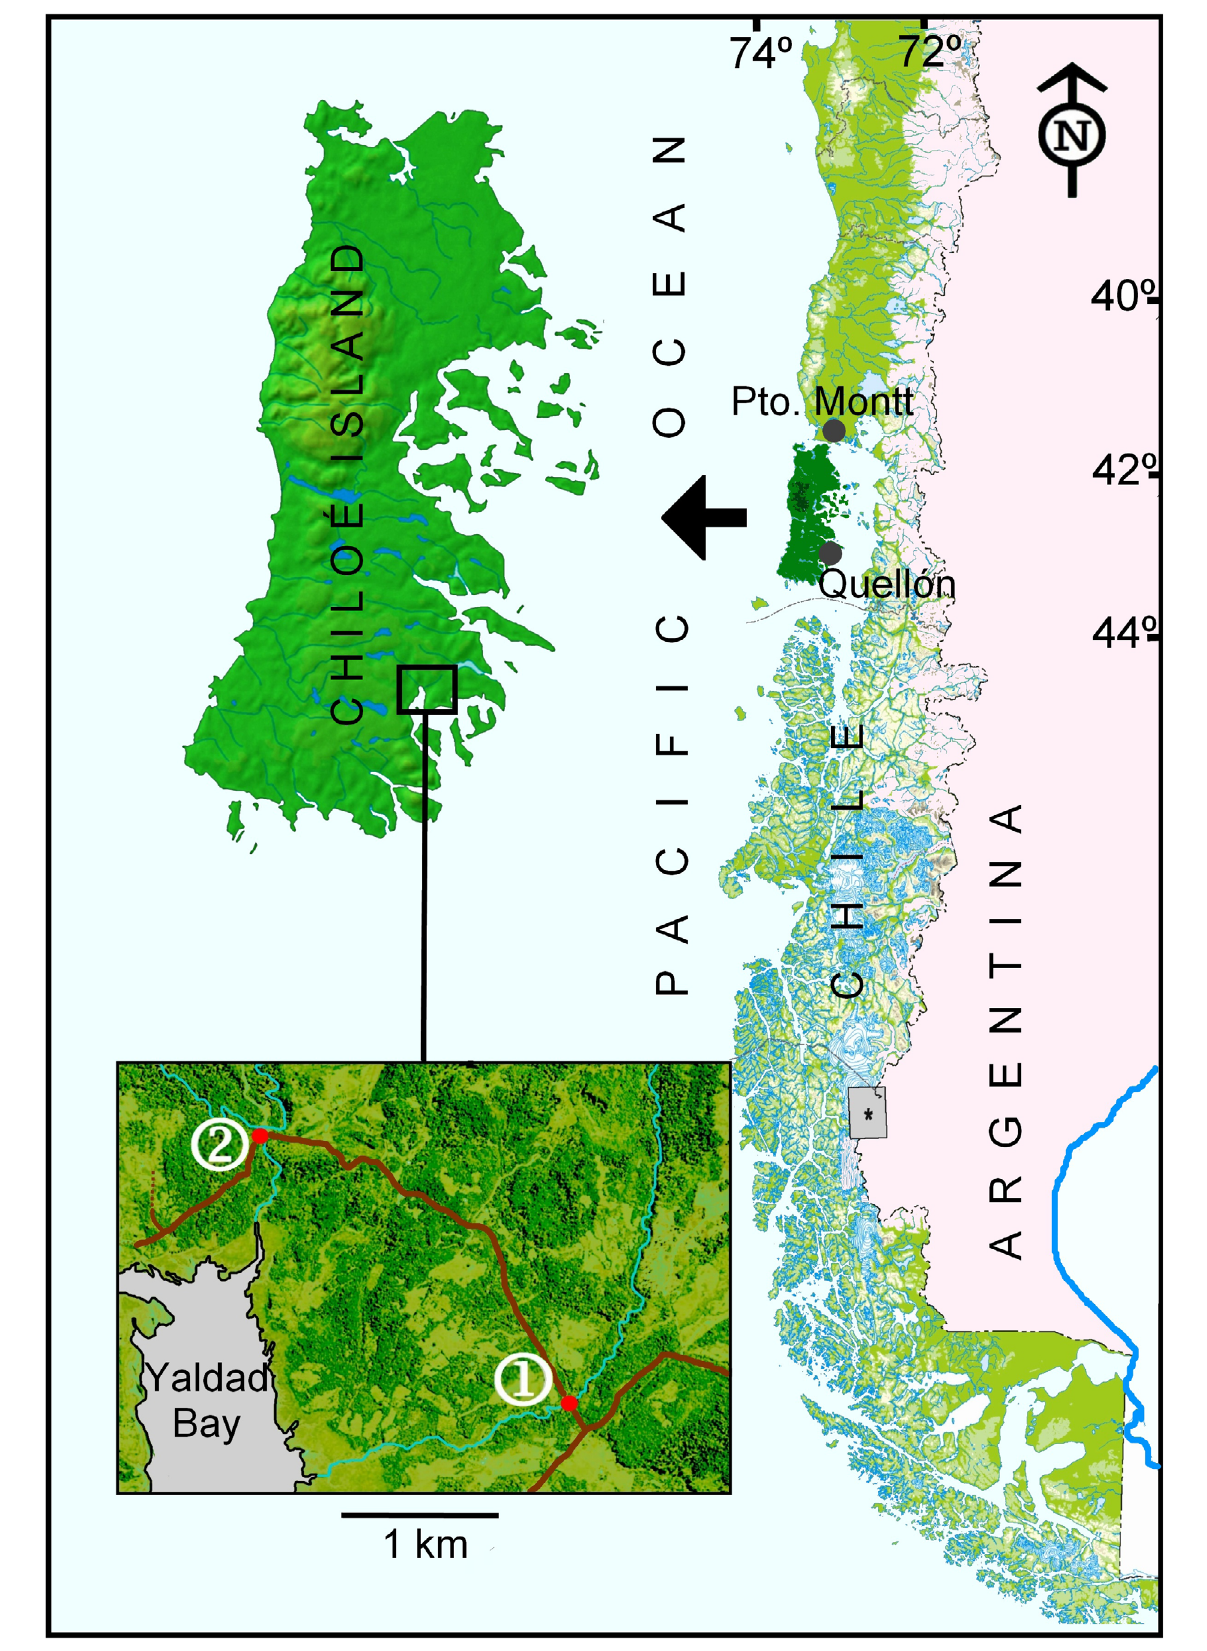
Figure 3. Map of Yaldad Bay showing the type locality of Aegla chilota n. sp. in the Incopulli River (1) and also the Yeco stream (2), from which additional specimens were